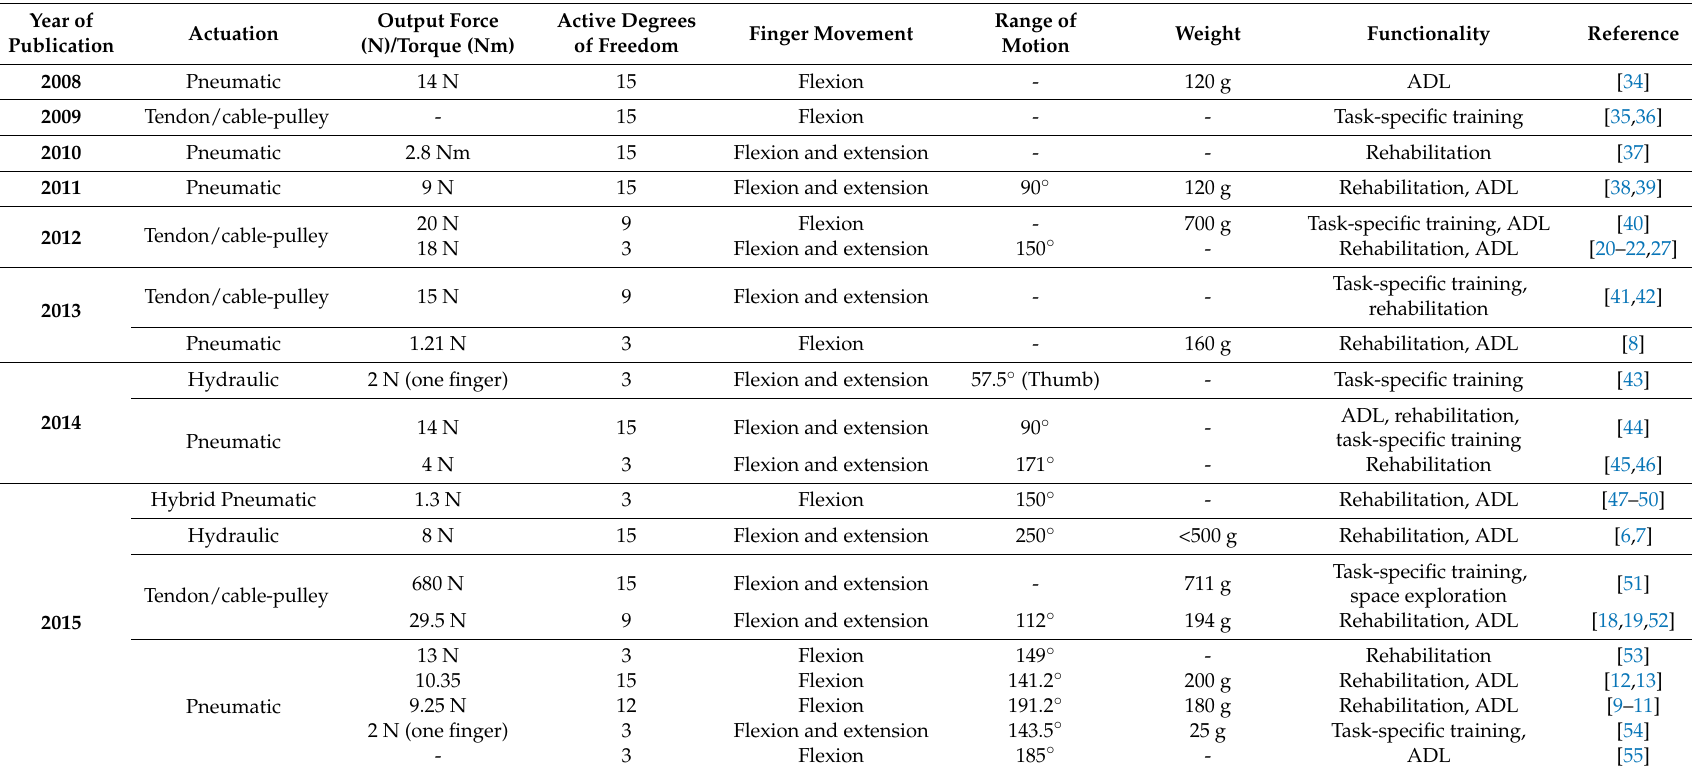
Table 1. Summary of the mechanical, electrical and functional attributes of soft robotic hand exoskeletons since